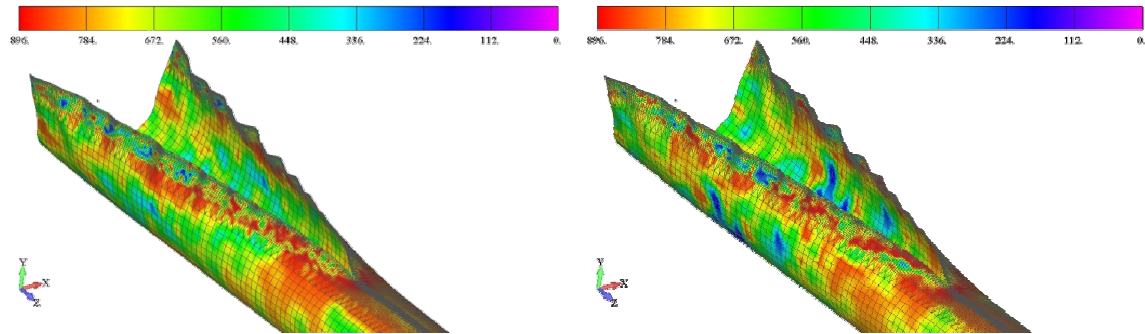
Figura 14: Andamento della tensione di Von Mises [MPa ] nel tubo in due step di calcolo successivi.